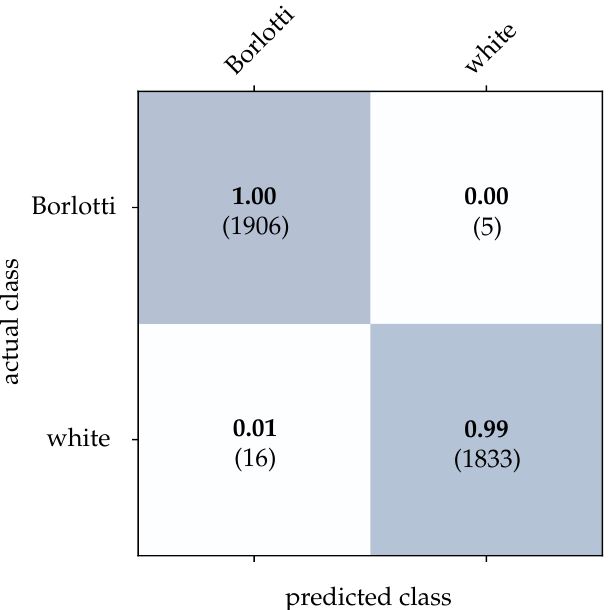
Figure 17. Classification results using MatrixLSTM [19] and the beans dataset. The bold values denote the relative frequency, the number in brackets the absolute number of samples.